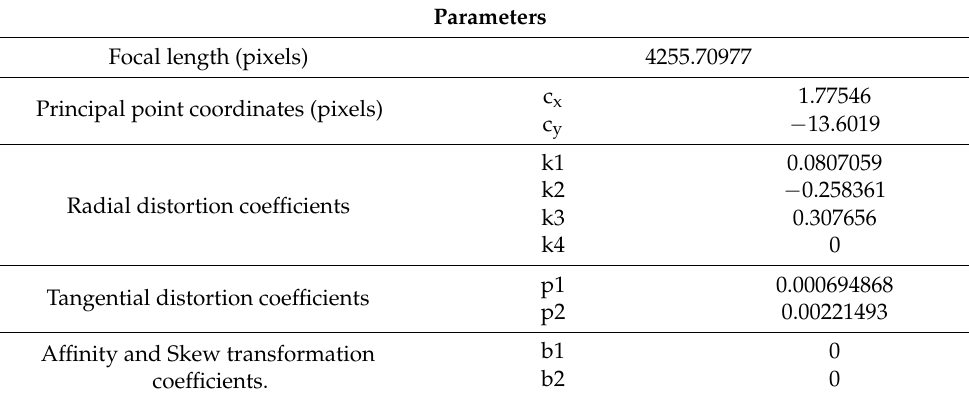
Table 6. Self-calibration parameters.